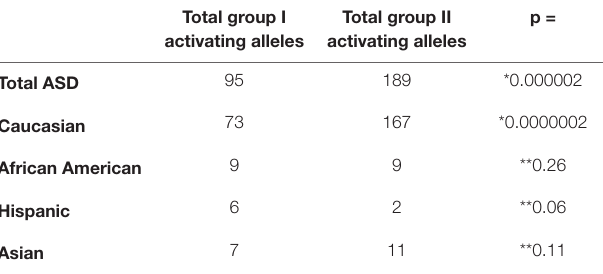
TABLE 4 | Over-representation of HLA-C group II activating alleles observed in